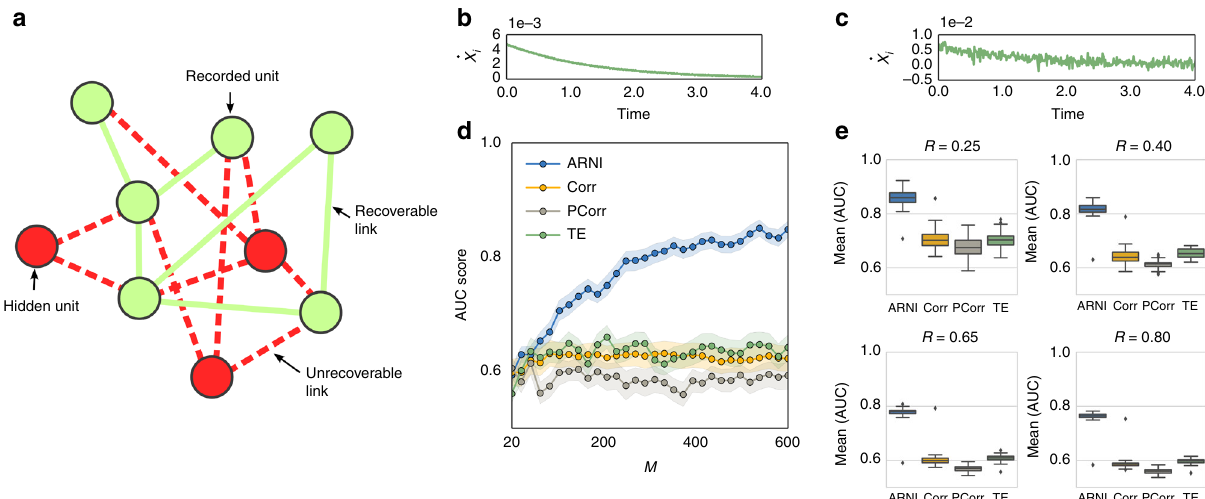
Fig. 6 Reconstructions are still viable if units are hidden and measurements are noisy. Revealing direct interactions within a subset of units from noisy transients toward steady states. The network size is fi xed at N = 100. a Representation of a network with a subset of measured units (green) and a subset of hidden units (red). b , c _ x i in noise-free and noisy transients. d Quality of reconstruction versus number of measurements employing our approach (ARNI), correlations (Corr), partial correlations (PCorr), and transfer entropy (TE) on a subset of 40 (randomly selected) recorded units. e Systematic reconstruction over different collections of subsets. The variable R indicates the fraction of recorded units. Averages over 50 random subsets of R < 1 indicate that our approach outperforms correlations, partial correlations, and transfer entropy across different R values